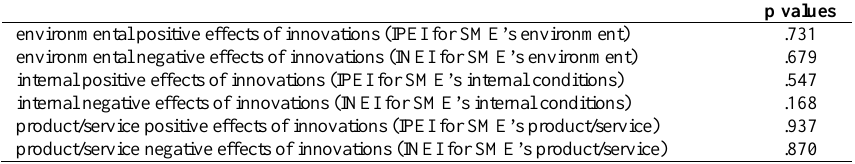
Table 5. P-value of H Kruskal-Wallis’ test for k independent samples: creators and other